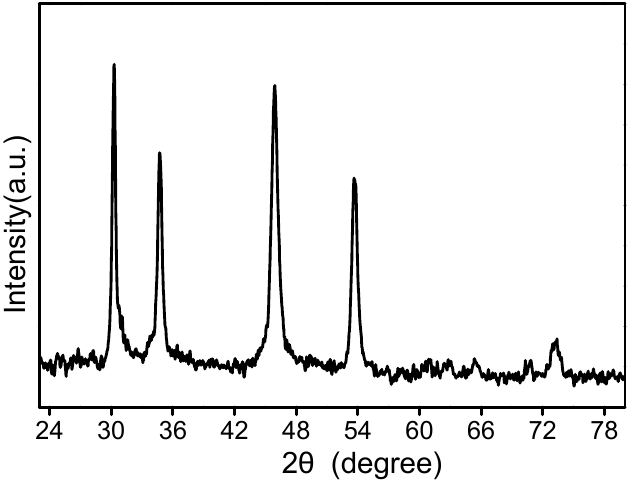
Figure 2. XRD pattern of the w-NiS-3D-Nf electrode .